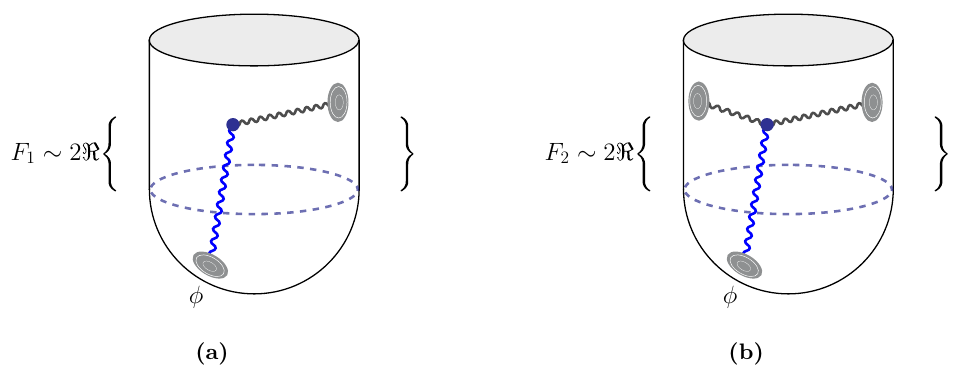
Figure 3. Diagrammatic representation of F 1 and F 2 to leading order in φ as Witten diagrams in pure AdS complexified manifolds. Analogous leading order contributions to the F observables and other more complex geometries are straightforward to